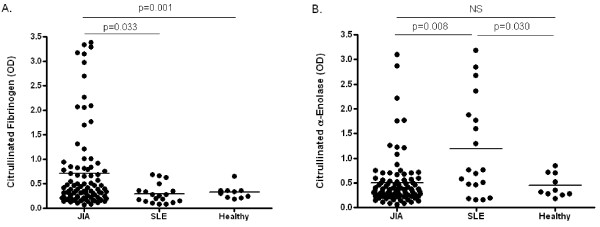
Levels of anti-citrullinated fibrinogen and g-enolase antibodies in JIA, SLE, and healthy children. IgG antibody recognition of citrullinated fibrinogen (a) and citrullinated α-enolase (b) by ELISA in sera from JIA patients (n = 96), SLE patients (n = 19), and healthy children (n = 10). Bars indicate the median levels of citrullinated antibodies in each group. P-values were considered statistically significant at < 0.05. OD: optical density.